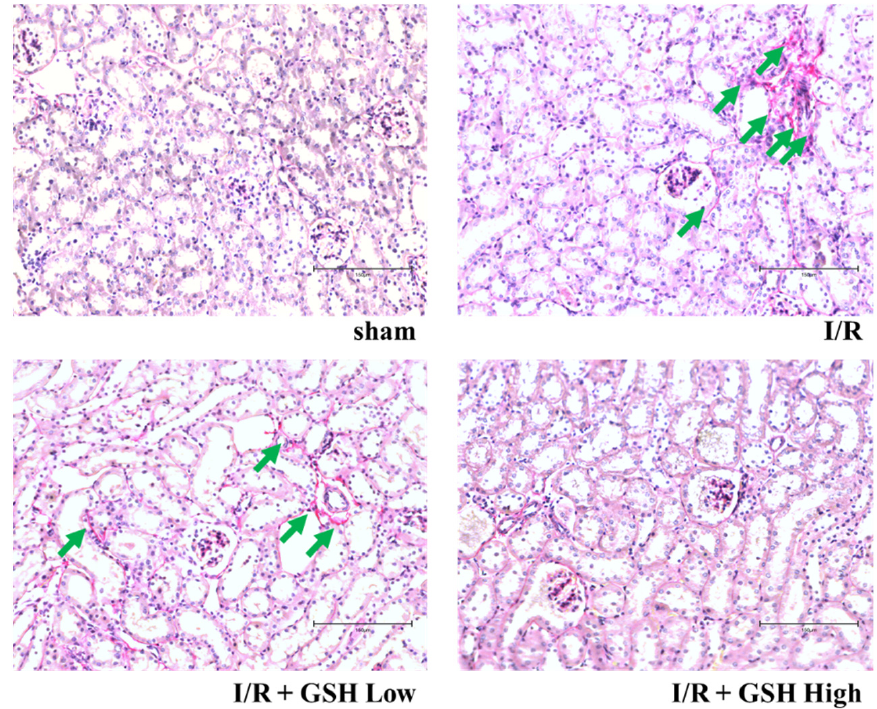
Figure 3. Effect of GSH on renal fibrosis in I/R-induced renal failure. Representative images of Picrosirius red staining for collagen deposition analysis in I/R-induced renal failure mice. Cardiomyocytes (purple) and collagen fibers (green arrow) were shown (magnification 400×, scale bar: 150 μ m).